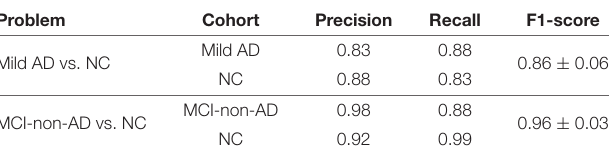
TABLE 4 | Classification metrics for the mild AD vs. NC and MCI-non-AD vs.